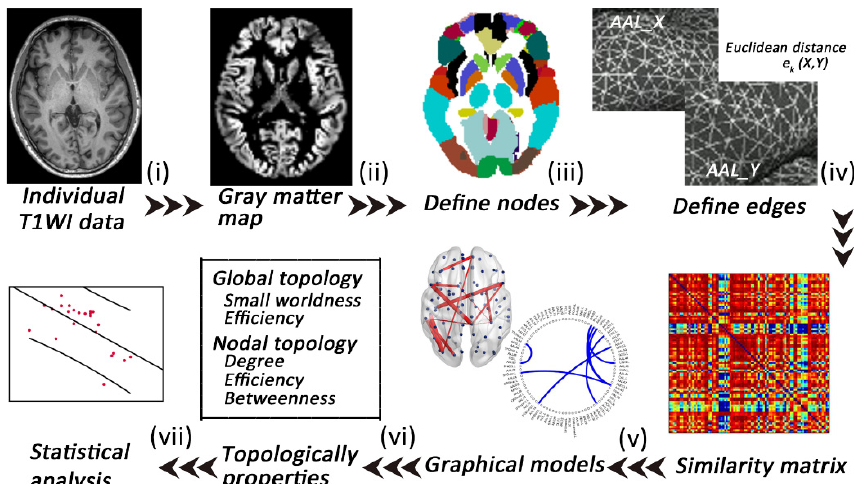
Figure 1. A flowchart of the construction of individual gray matter MBNs. ( i ) High-resolution T1-weighted imaging and ( ii ) data preprocessing (segment, normalize, modulate, and smooth); ( iii ) nodes are defined according to the automated anatomical labeling (AAL) atlases; ( iv ) edges are defined according to the combined Euclidean distance method; ( v ) an individual similarity matrix is obtained; ( vi-vii ) network properties are calculated and analyzed.